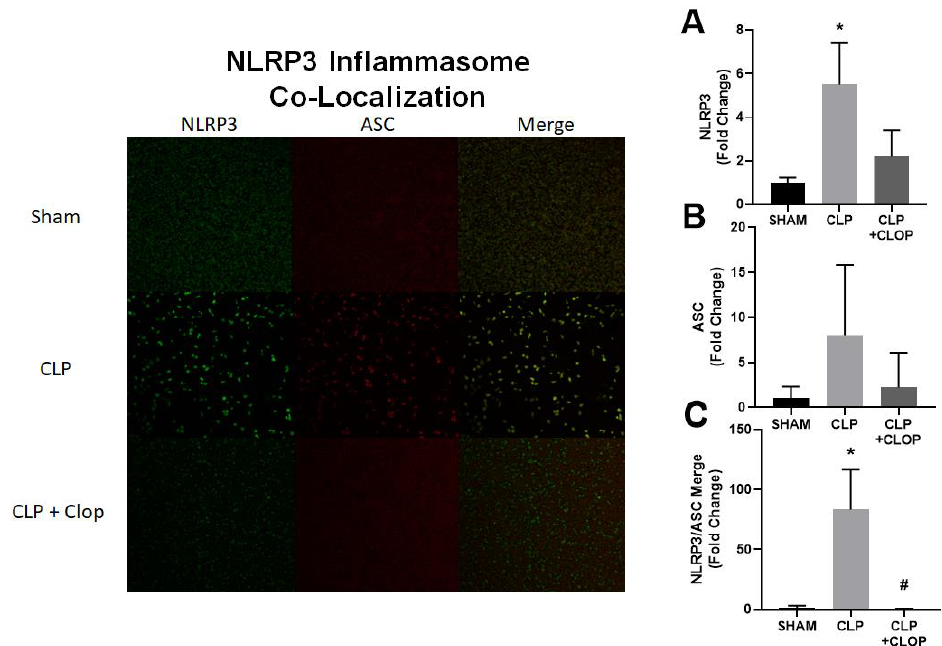
Figure 2. NLRP3 Inflammasome. ( A – C ) NLRP3 inflammasome activation was evaluated by visualizing the co-localization of NLRP3 and apoptosis-associated speck-like protein (ASC) using immunocytochemistry. * p < 0.05 vs. Sham, # p < 0.05 vs. CLP.